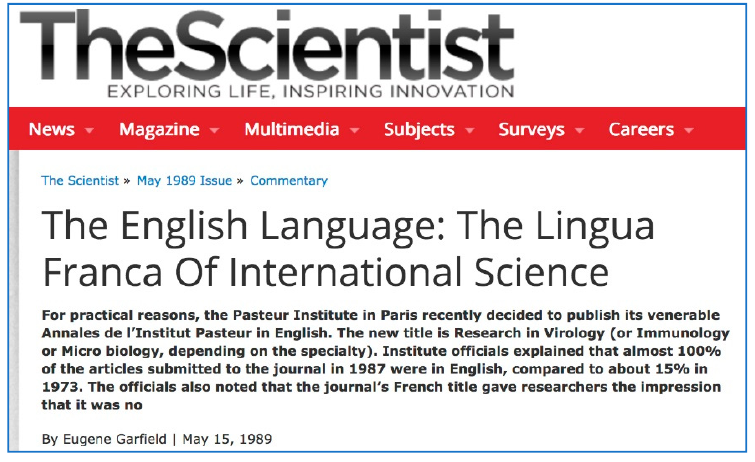
Figure 6. An article by Eugene Garfield promoting English as the international language of science published in The Scientist magazine. Reproduced with permission from The Scientist .